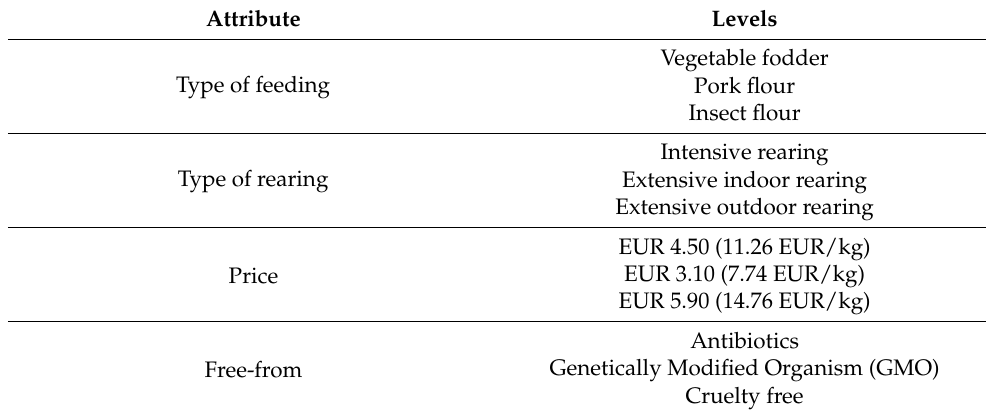
Table 2. Attributes and levels used to create the best–worst scaling.